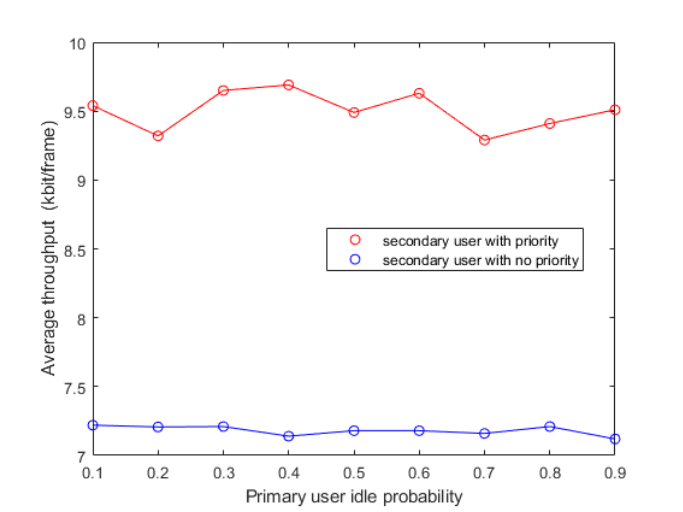
Figure 8. Average throughput of priority strategy versus primary user idle